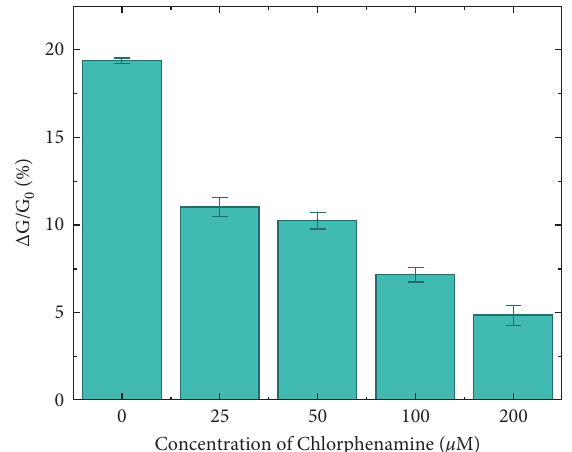
Figure 5: Reduction of histamine-induced Ca 2+ release from the intracellular stores of HeLa cells pretreated with chlorphenamine at different concentrations in the range of 0–200 μ M. The responses of the HeLa cells were monitored by the measurement of the con- ductance changes of only a SCN device. Data are expressed as mean ± SD (standard deviation) ( n �